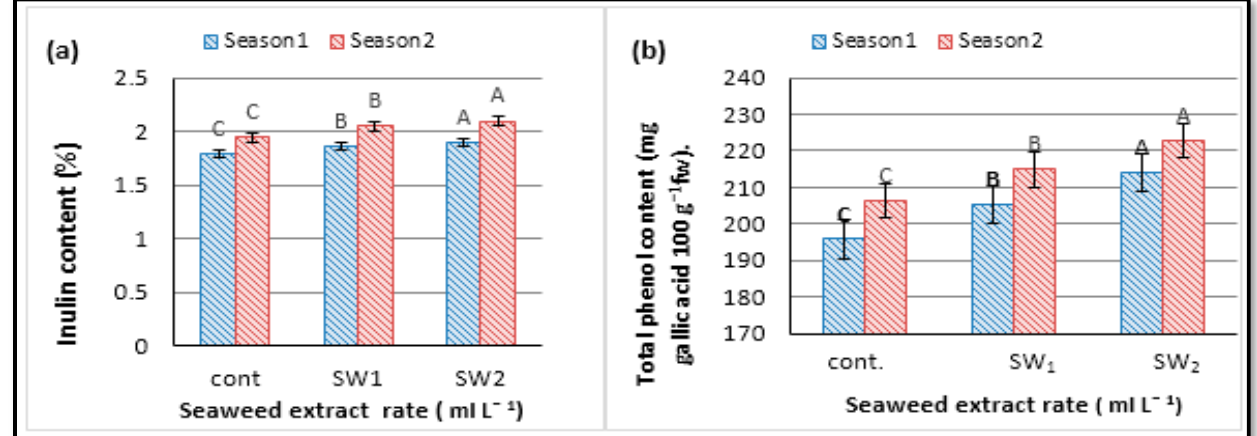
Figure 8. Head mineral contents (mean ± SE) of globe artichoke as affected by seaweed extract rate (Control: without, SW 1 : 5 and SW 2 : 10 mL L − 1 ) on ( a ) Nitrogen (%); ( b ) Phosphorus (%) and ( c ) Potassium (%). Letters in the figures indicate that the mean ± SE treatments with the same letters were not significantly different according to Duncan’s multiple range test for p < 0.05.